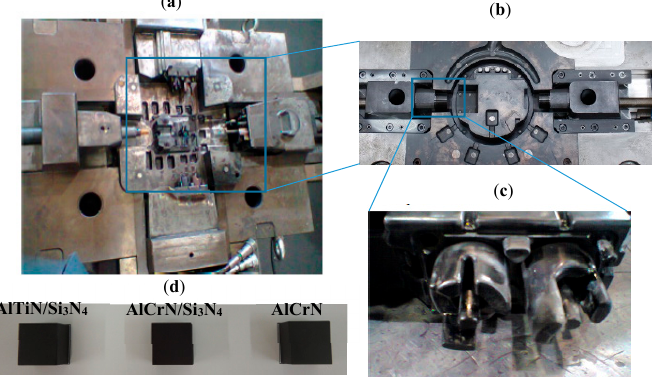
Figure 1. Set of coated samples ( a ) General view from the coated mold; ( b ) cavity details; ( c ) core pins; and ( d ) H13 blocks used for coating characterization studies.